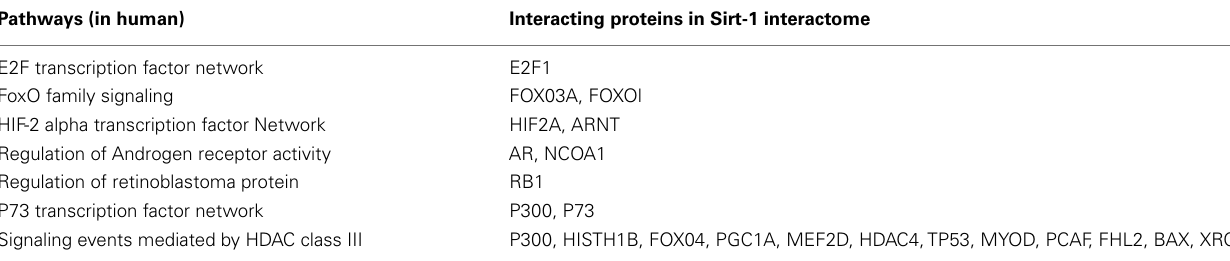
TableA3 | Interacting protein partner of Sirt-1 involved in various pathways. Pathways (in human)